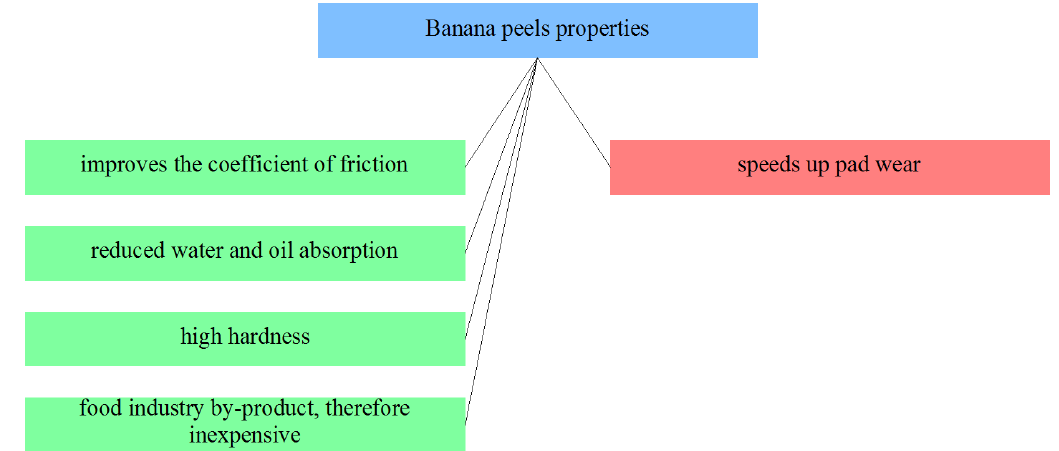
Figure 15: Selected banana peels properties from the point of view of applicability in friction